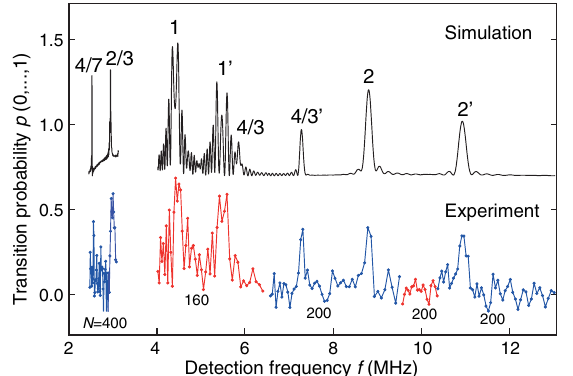
FIG. 5. Spectrum recorded by a NV center coupled to its own 14 N nucleus, measured using an XY 8 sequence. The common coupling constant is a ⊥ = 2 π ¼ 280 kHz. This coupling is due to a deliberate misalignment of the bias field of around 8° with respect to the NV symmetry axis. Further experimental parameters are similar to Fig. 4.